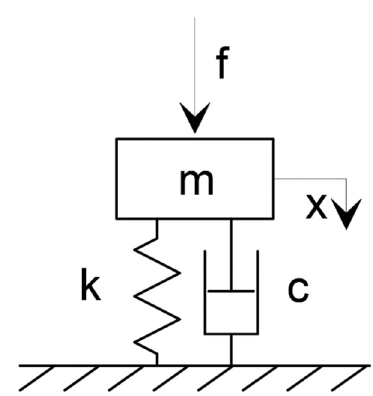
Figure 2. Single-degree-of-freedom mass–spring–damper system [30], where m is the mass of the system, c is the damping, k is the stiffness, f is the excitation force and x is the displacement.